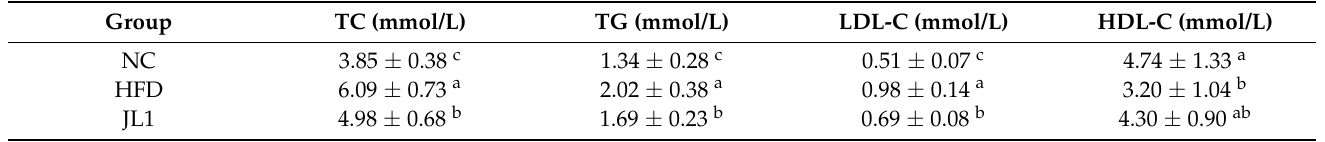
Table 4. Effect of L. rhamnosus JL1 on the levels of serum lipids in